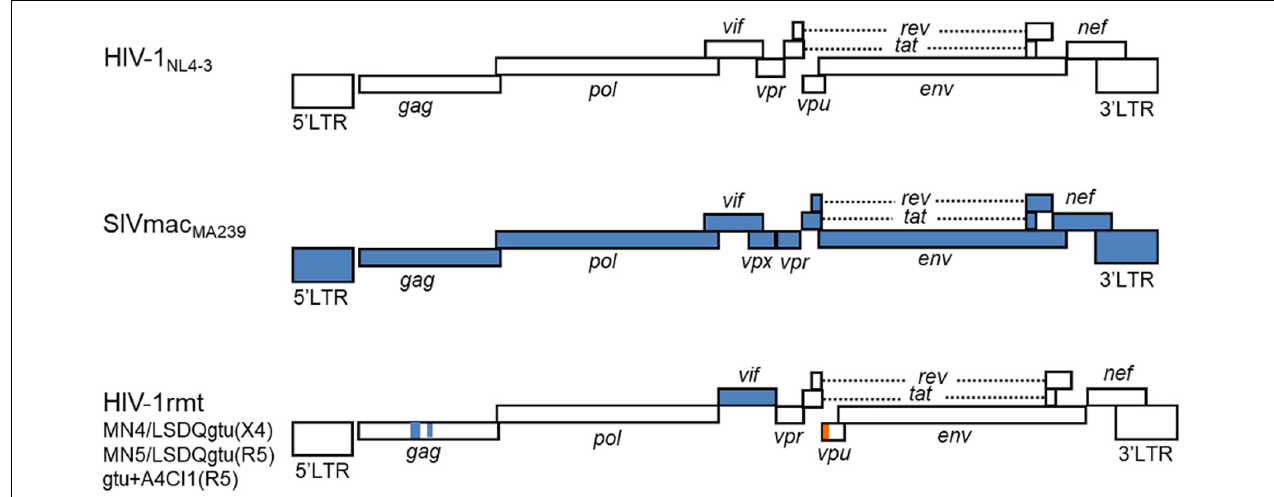
FIGURE 1 | Basic genome structure of HIV-1rmt clones. The three HIV-1rmt clones indicated have been constructed from three distinct primate immunodeficiency viruses as shown. Genomic regions of HIV-1rmt clones derived from HIV-1 NL4-3, SIVmac MA239, and SIVgsn 166 (SIV isolated from the greater spot-nosed monkey) are depicted by white, blue, and orange areas, respectively. Generation and characterization of HIV-1 NL4-3 (Adachi et al., 1986), SIVmac MA239 (Shibata et al., 1991), CXCR4-tropic HIV-1rmt designated MN4/LSDQgtu (Nomaguchi et al., 2013b; Nomaguchi et al., 2017), CCR5-tropic HIV-1rmt